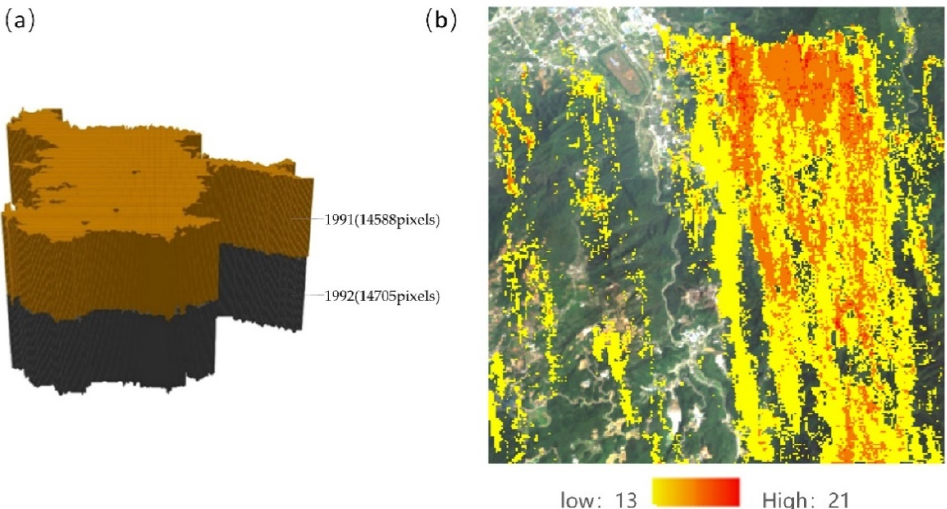
Figure 11. ( a ) Actual SL IST-cube diagram containing two layers representing two years. The average number of pixels per year is 14 647, conforming to the criterion for the SL IST-cube class. ( b ) Spatial distribution map of occurrence number for the SL IST-cube.